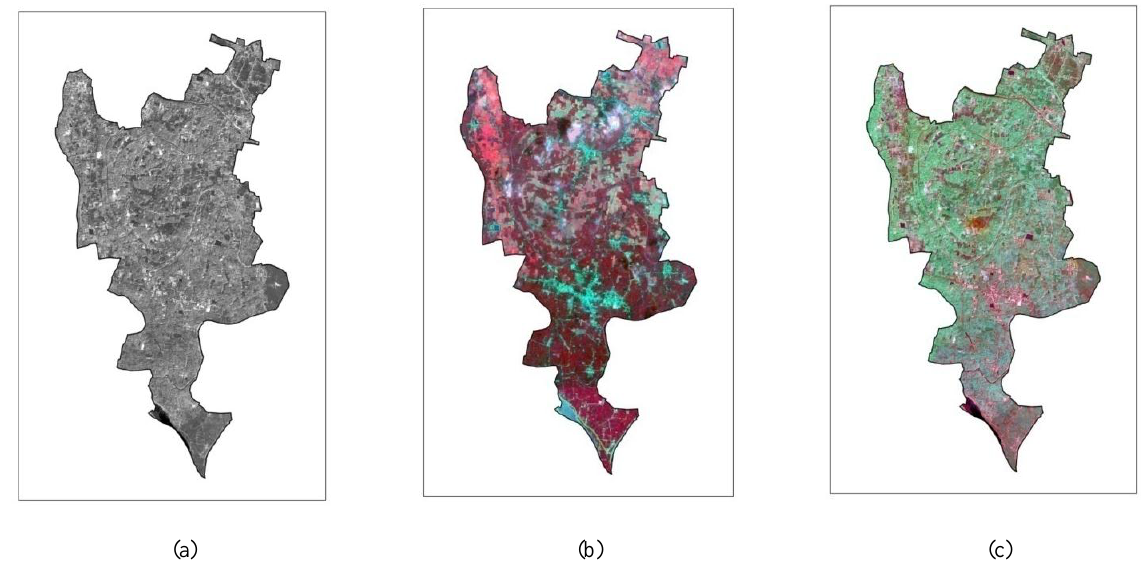
Figure 3: (a) CARTOSAT-I (2.5m) (b) LISS-IV (5.8m) and (c) Fused Product (2.5m)